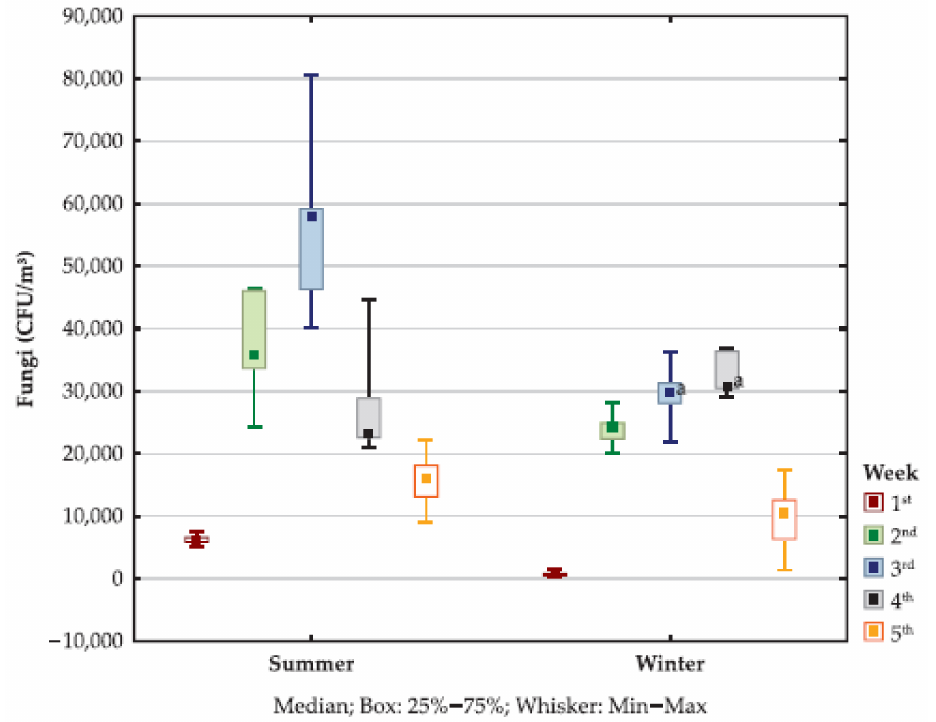
Figure 1. Airborne fungi in broiler house according to fattening weeks in summer and winter. a All values within the same season differ significantly ( p < 0.05), except for the marked ones. All values within the same weeks differ significantly between the seasons ( p <